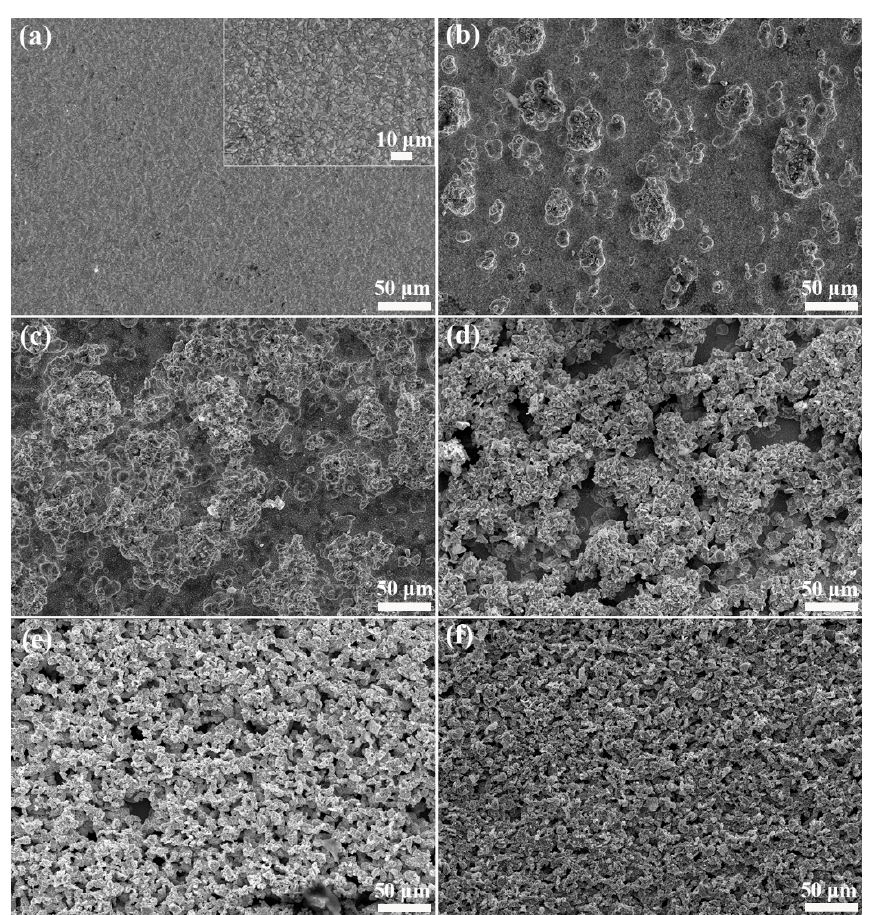
Figure 2. SEM morphologies of the Ni–Cr–graphene coatings electrodeposited with 0 g/L Cr particles ( a ) and 25 g/L Cr particles with various graphene concentrations of 0 ( b ), 1 ( c ), 2 ( d ), 4 ( e ), and 8 ( f ) g/L.